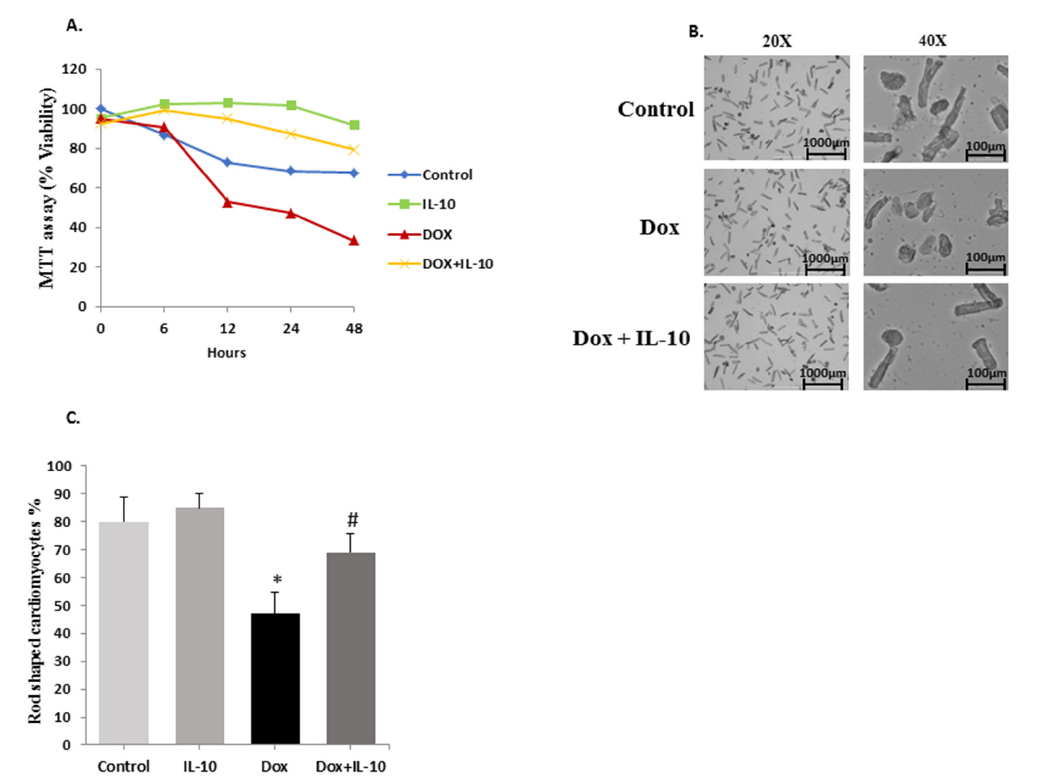
Figure 1. IL-10 improves cardiomyocyte viability. ( A ) Cardiomyocyte viability in different treatment groups treated with Dox (5.43 µ g/mL) in the presence or absence of IL-10 (10 ng/mL) at different time points using MTT assay. ( B ) Phase contrast microscopic images of different groups after 24 h of treatment at 20X and 40X, scale bar 1000 µ m and 100 µ m, respectively. ( C ) The average percentage of rod-shaped cardiomyocytes at 24 h of Dox, 10 µ M treatment in the presence or absence of IL-10, 10 ng/mL as % of control. Data are means +/- SE from 4 individual experiments. * p < 0.01 vs. control, IL-10; # p < 0.01 vs. Dox.